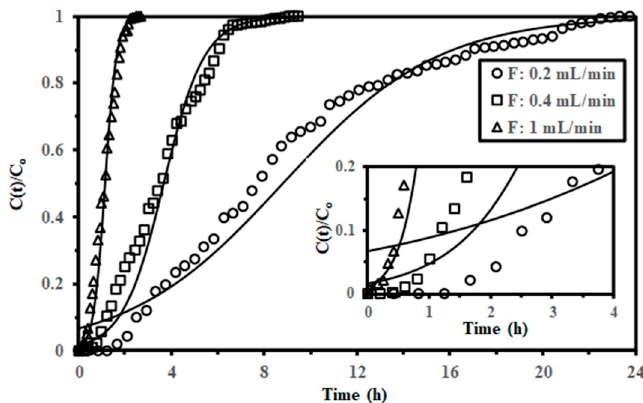
Figure 6. Effect of flow rate on the breakthrough curves for the sorption of Sr(II) using AO-APEI in fixed-bed reactor – Modeling with the Thomas equation [87] (sorbent mass: 70 mg d.w.; bed volume: 5 mL; column depth: 4.4 cm; column diameter: 5 mm; C 0 : 54.3 mg Sr L − 1 ; pH inlet : 6.0; room temperature: 25 ± 1 °C).